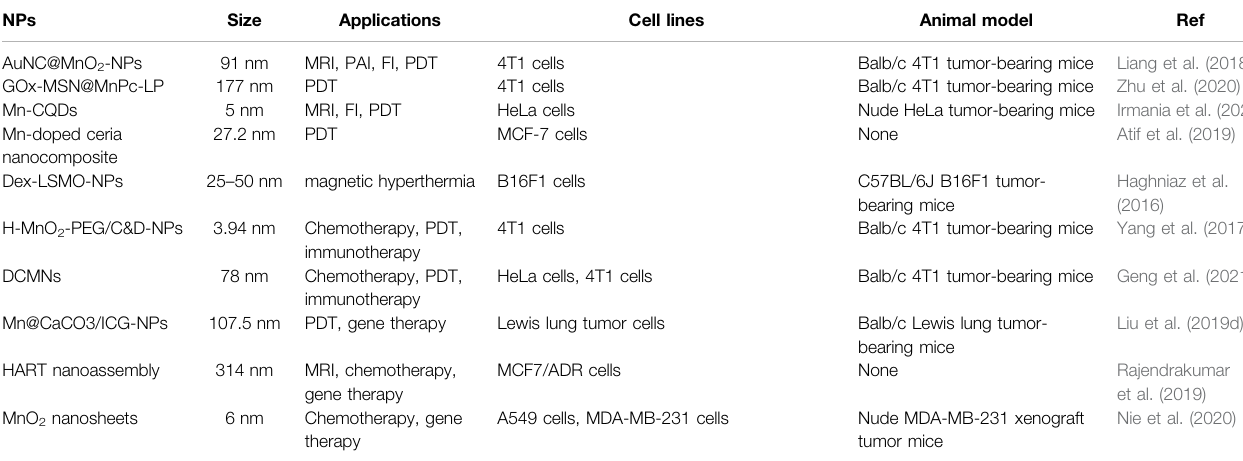
TABLE 1 | ( Continued ) Summary of the application of Mn-NPs in cancer diagnosis and